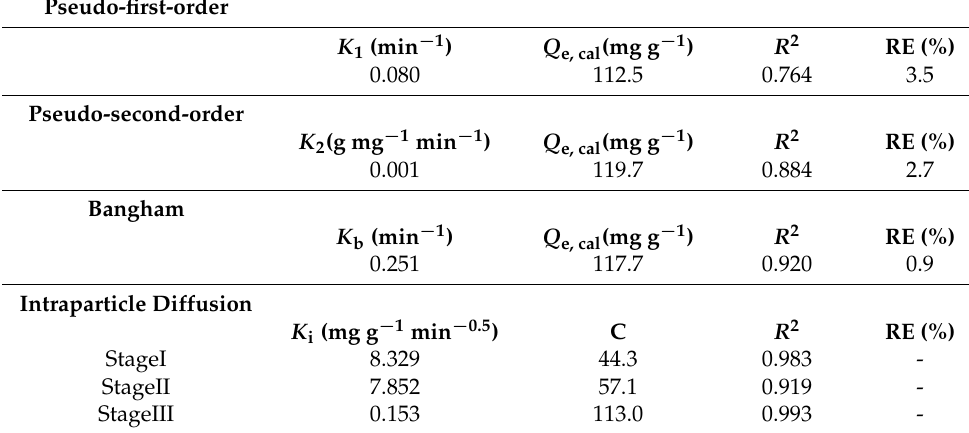
Table 2. Kinetic parameters in the DEMs adsorption onto cotton